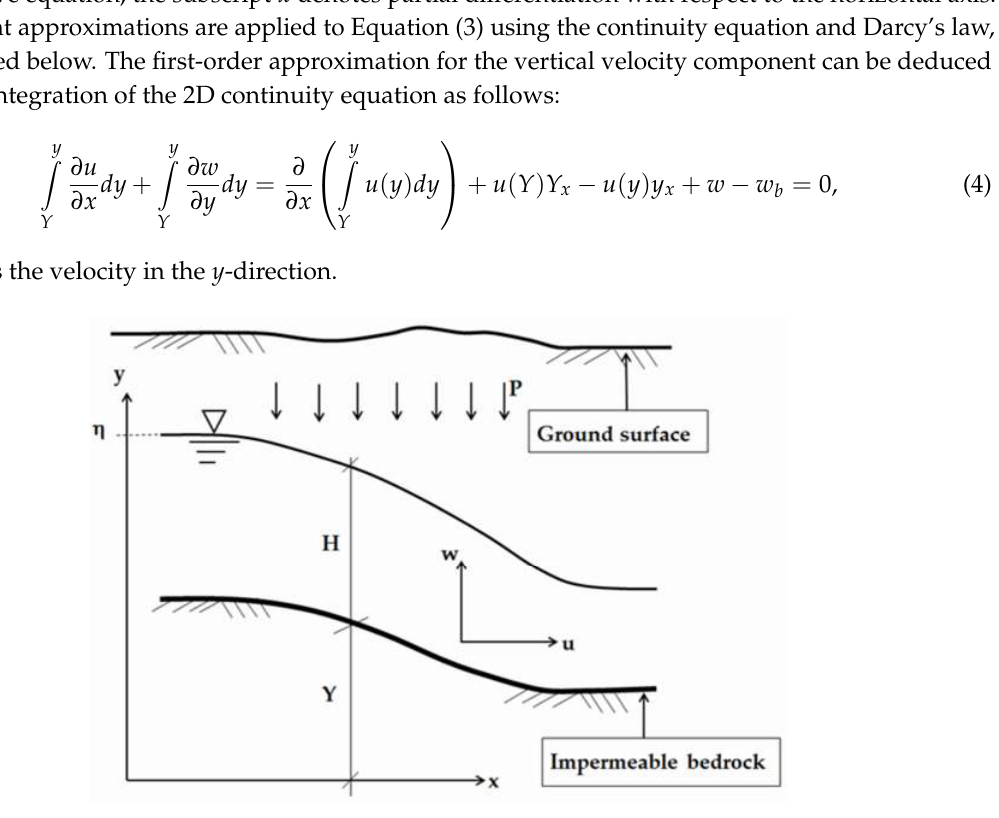
Figure 1. Definition sketch, showing a Cartesian coordinate system for a non-hydrostatic groundwater flow.